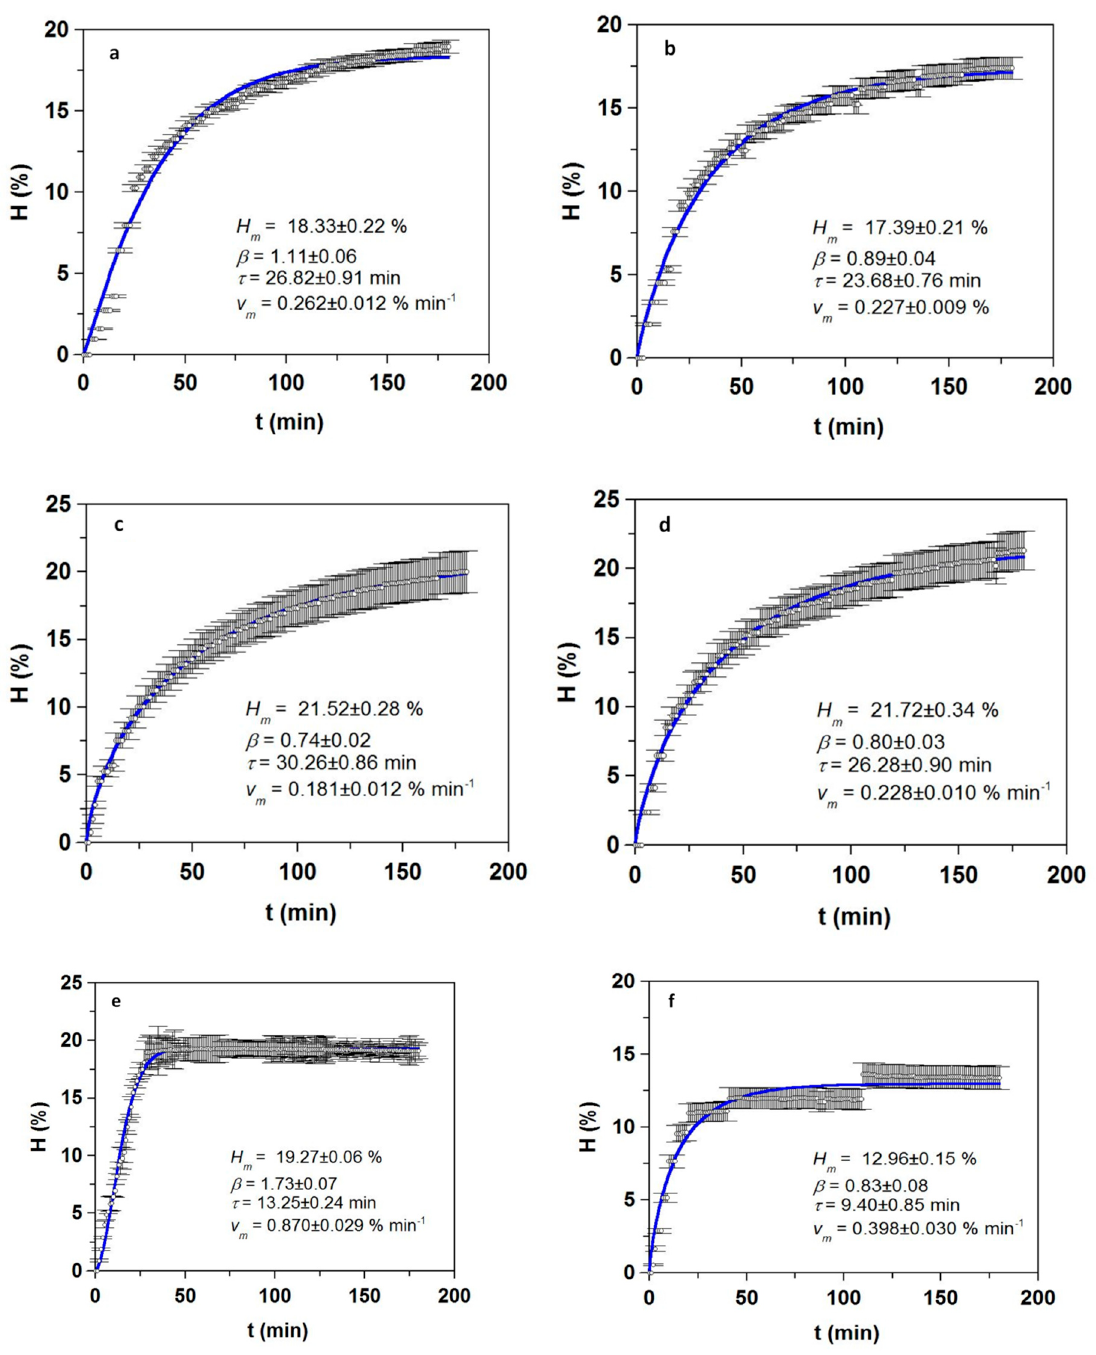
Figure 3. Kinetics of the hydrolysis of heads ( a , b ), frames and trimmings ( c , d ) and viscera ( e , f ) of seabream ( a , c , e ) and seabass ( b , d , f ). Experimental data of hydrolysis degree (symbols) were described by Equation (2) (continuous line). Error bars are the confidence intervals for n = 2 (replicates of different hydrolysates) and α = 0.05.